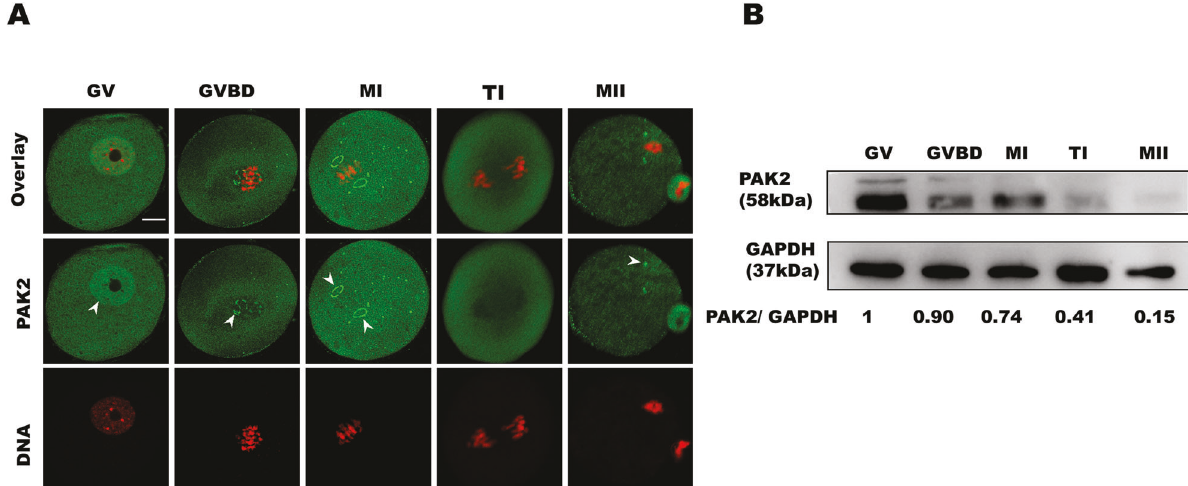
Fig. 1 Subcellular localization and expression of PAK2 during oocyte maturation. A Confocal microscopy showing immunostaining for PAK2 (green) and DNA (red) in mouse oocytes at GV (germinal vesicle), GVBD (germinal vesicle breakdown), MI (metaphase I), TI (telophase I), and MII (metaphase II) stages. B Expression of PAK2 during meiotic maturation at GV, GVBD, MI, TI, and MII stages (the molecular mass of PAK2 is 58 kDa). Proteins from 200 oocytes were loaded for each sample (scale bar = 20 μ